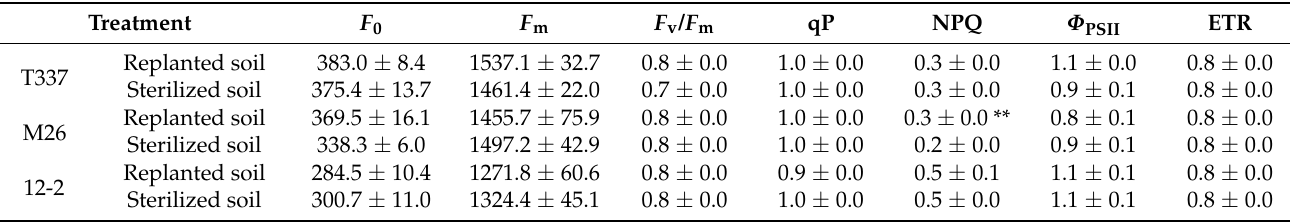
Table 3. Fluorescence in the leaves from plants with different rootstock types planted in sterilized and replanted soil on 10